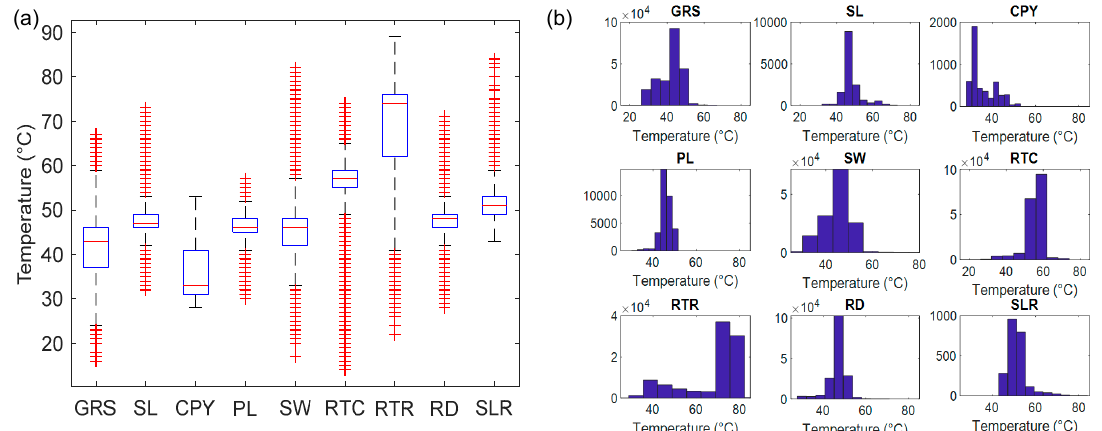
Figure 3. Boxplot distribution of surface temperature ( a ); and histogram of surface temperature ( b ). Data from flight recorded on July 11, 2018. Note GRS = grass; SM = shrub / mulch; CPY = canopy; PL = parking lot; SW = sidewalk; RTC = composite rooftop; RTR = rubber rooftop; RD = road; SLR = solar.